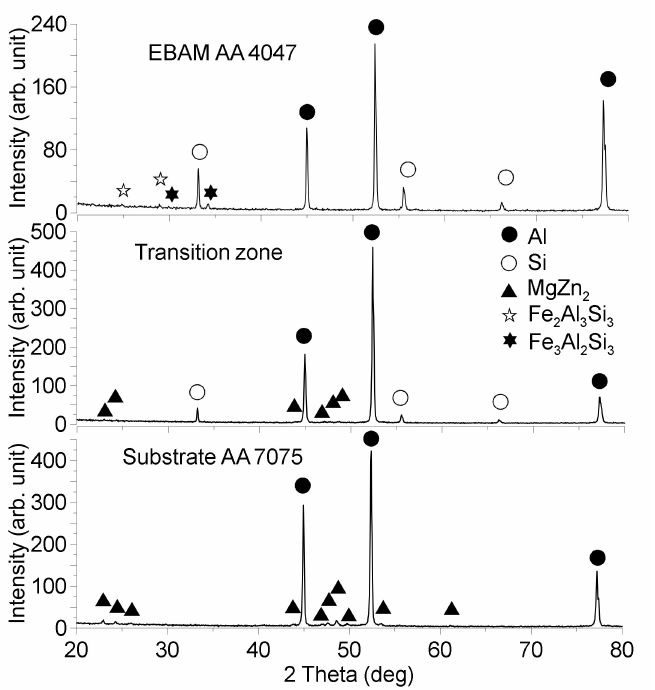
Figure 6. XRD patterns for AA7075 substrate, AA7075/AA4047 transition zone and deposited AA4047.